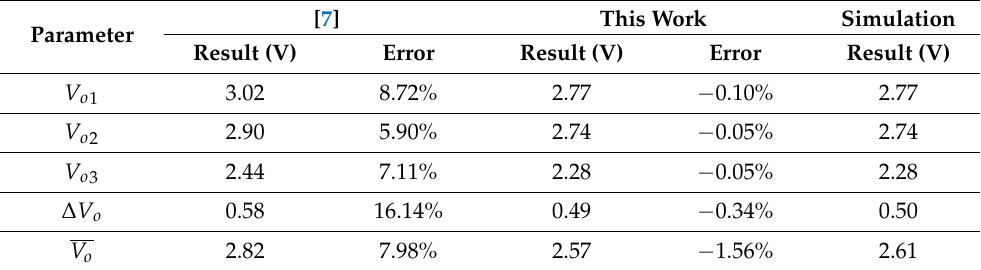
Table 1. The simulation result for 1-stage linear charge pump.